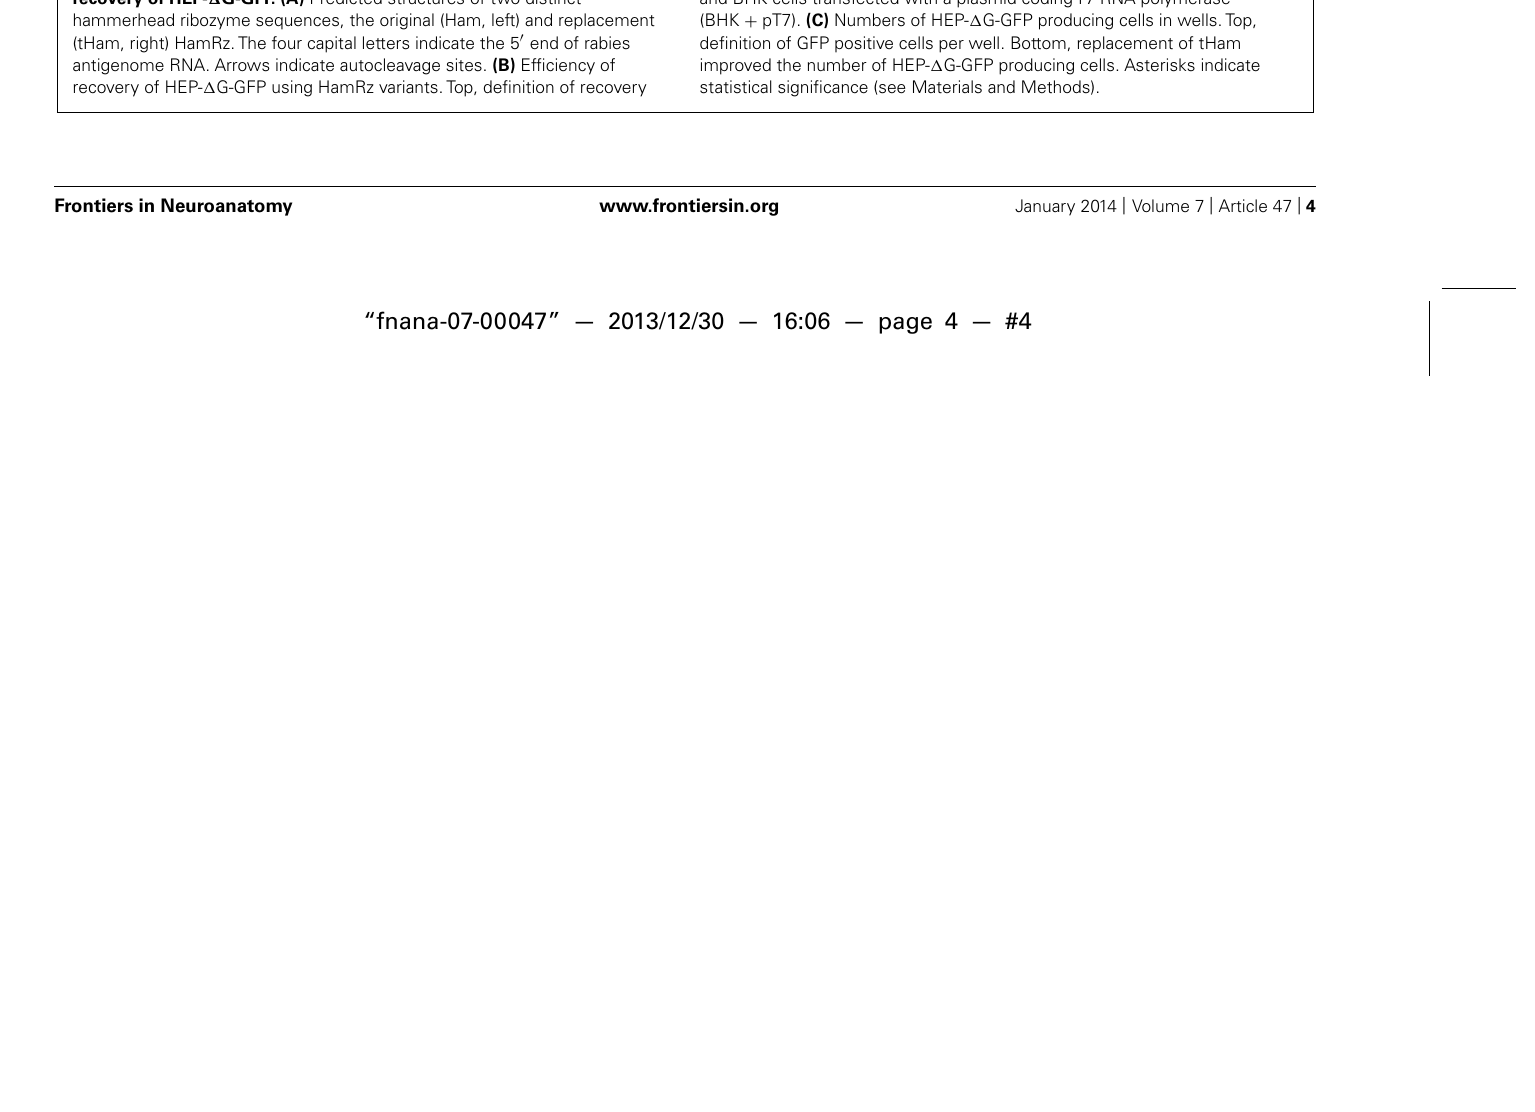
efficiency. Efficiency of recovery of HEP- Δ G-GFP on BHK-T7/9 (BHK-T7) and BHK cells transfected with a plasmid codingT7 RNA polymerase (BHK + pT7). (C) Numbers of HEP- Δ G-GFP producing cells in wells.Top, definition of GFP positive cells per well. Bottom, replacement of tHam improved the number of HEP- Δ G-GFP producing cells. Asterisks indicate statistical significance (see Materials and